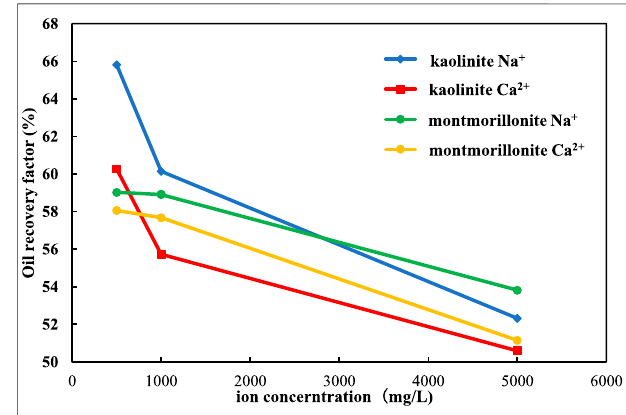
FIGURE 11 | Oil recovery of montmorillonite sand packs displaced by different salinity of CaCl 2